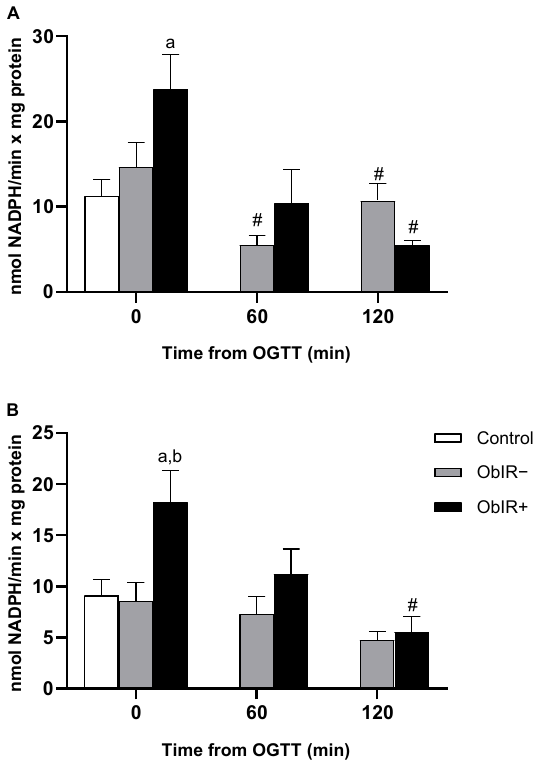
Figure 4. NADP + -dehydrogenase Activity in RBCs of healthy and obese children. Glucose-6-phosphate dehydrogenase ( A ) and 6-phosphogluconate dehydrogenase ( B ) activities were measured in RBCs at baseline and along OGTT. White bars represent the control group, grey bars represent ObIR − group, and black bars represent ObIR+ group. Values are means ± SEM. p < 0.05 was considered for statistical significance. (a) shows significant differences relative to control at baseline, (b) shows significant differences relative to ObIR − , and ( # ) shows intragroup differences along the OGTT.